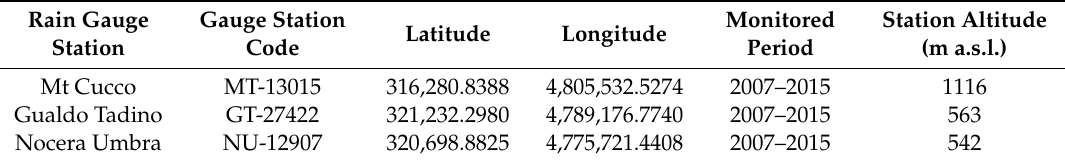
Table 2. Location and characteristics of rain gauge station (geographic coordinate system is expressed in WGS84 UTM Zone 33).